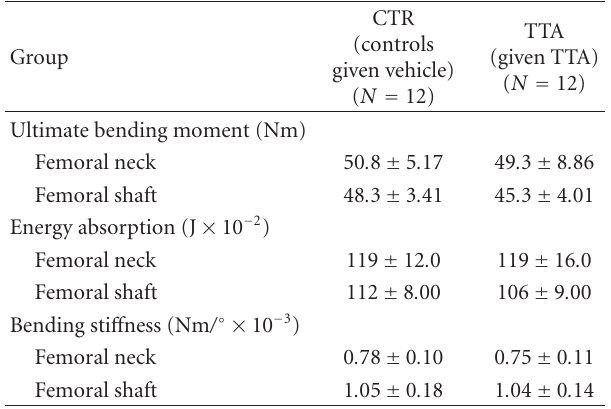
Table 3: Mechanical properties of femoral neck and shaft after four months of treatment with TTA (Study